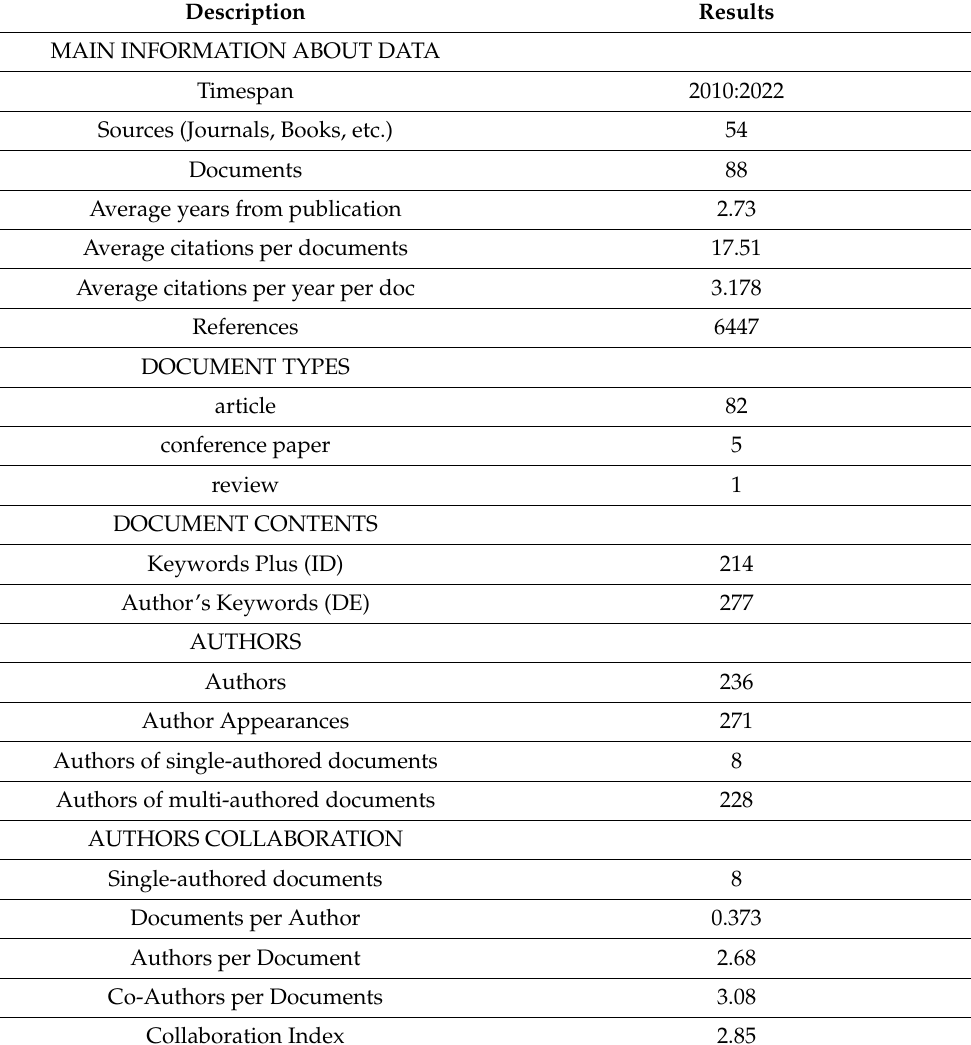
Table A1. Descriptive characteristics of TMT characteristics and environmental